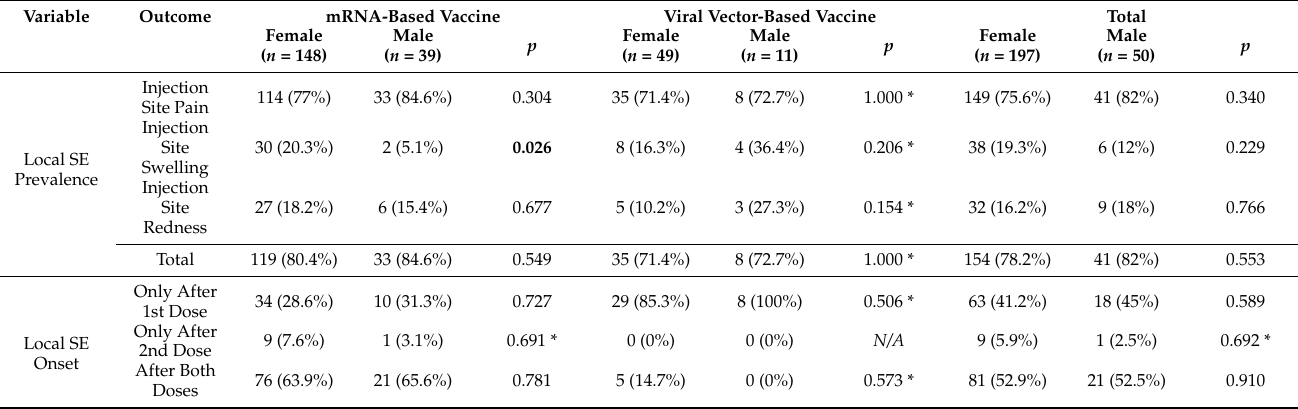
Table 8. Local, systemic, orofacial and skin-related SRAEs and palliative drugs taken after COVID-19 vaccination stratified by